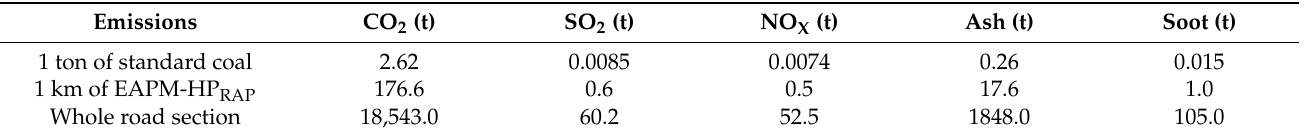
Table 11. Emission reductions achieved by using EAPM-HP RAP instead of regular asphalt as an upper base